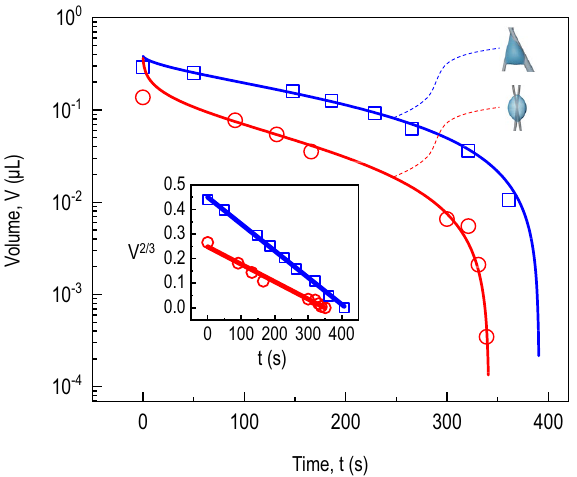
Figure 3. Evaporation dynamics of an irregular water droplet on glass wires. The droplet volume was measured by 4D X-ray microtomography for the initial 0.1 μL water droplet (circles: the crossing angle of the wires is ◦ 22.07 , the same droplet in Fig. 2) and for the initial 0.3 μL water droplet (squares: the crossing angle of the ◦ wires is 36.84 ). The solid red and blue lines, taken from a power-law scaling, demonstrate that the droplet 2 / 3 volume rapidly decreases with time. To understand the evaporation mechanism, we evaluate the volume 2 / 3 versus time (in the inset), demonstrating the linearity between V and t (illustrated by the solid red and blue lines). This result suggests that the evaporation dynamics of an irregular droplet are governed mainly by the effective contact radius (equivalent to the contact surface area) induced by the topological heterogeneity.